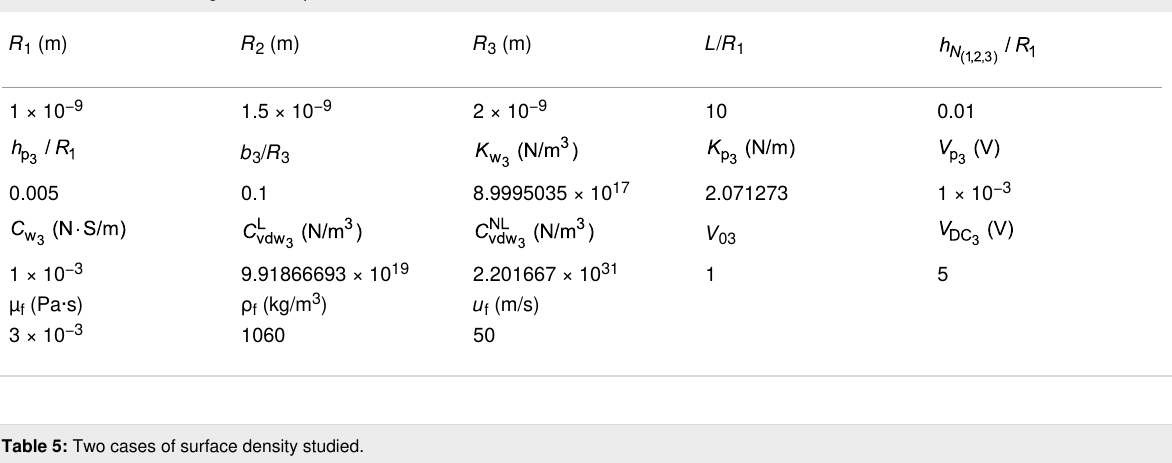
Table 4: The material and geometrical parameters of FC-MWPENS.